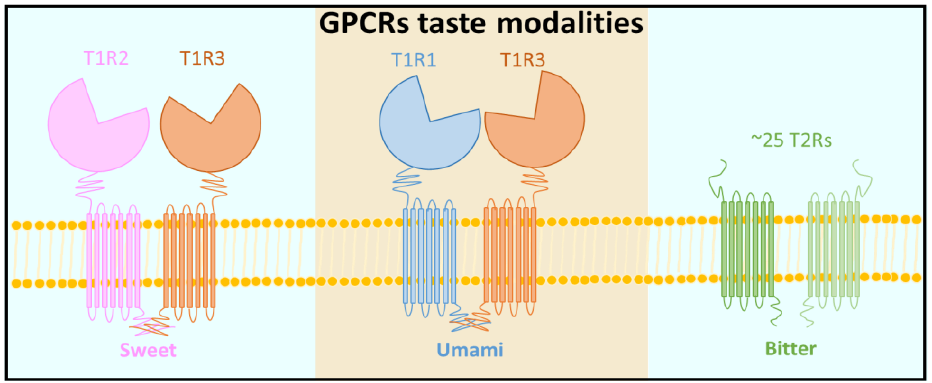
Figure 2. Receptor components for sweet, umami and bitter tastes.